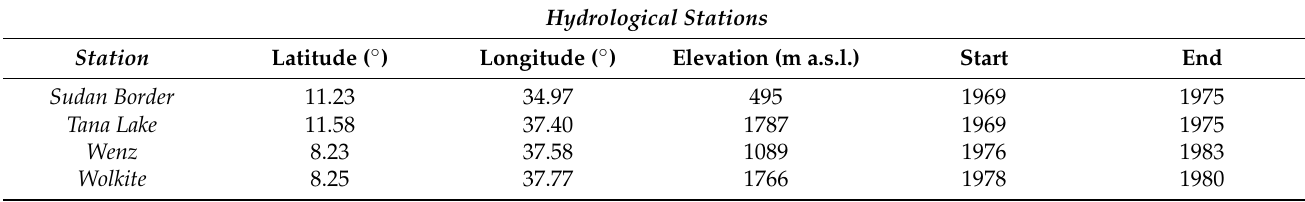
Table 3. Hydrological stations used in the study. Hydrological